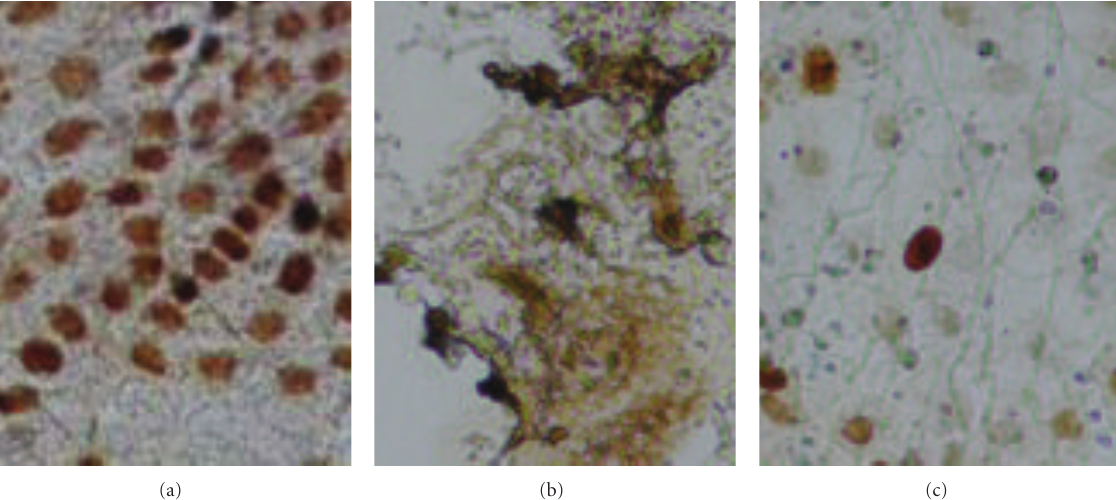
Figure 2: Pneumococcal cell wall component peptidoglycan-polysaccharides (PGPSs) stimulate the proliferation (a) of rat middle ear epithelial cells whereas endotoxin (LPS) causes the death of the cells (b) compared with carrier treated cells (c). Cells were incubated with PGPS at 20ng/mL for 6 hours and stained with PCNA antibody. Brown in color indicates cell nuclei with positive PCNA